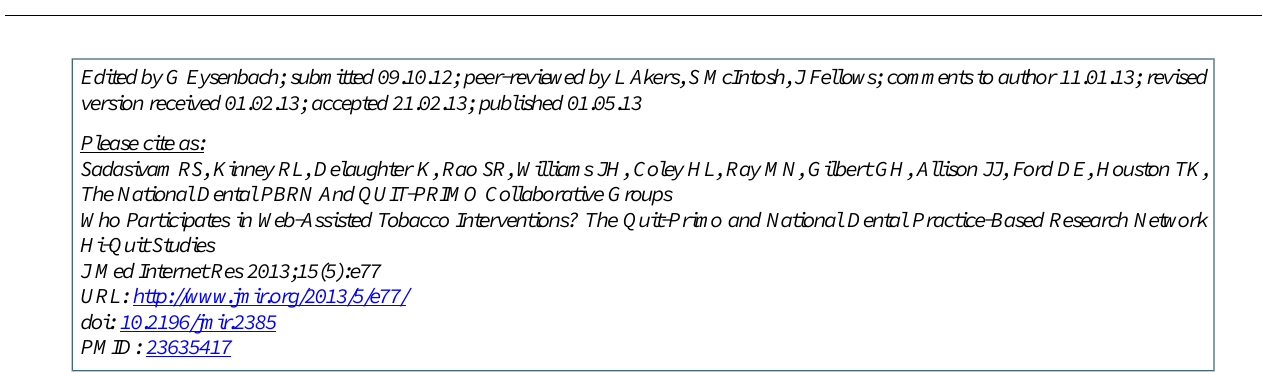
BRFSS: Behavioral Risk Factors Surveillance Survey IRR: incidence rate ratio TTS: tobacco treatment